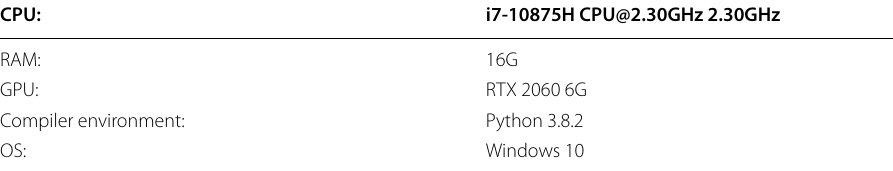
Table 2 Experimental environment of this